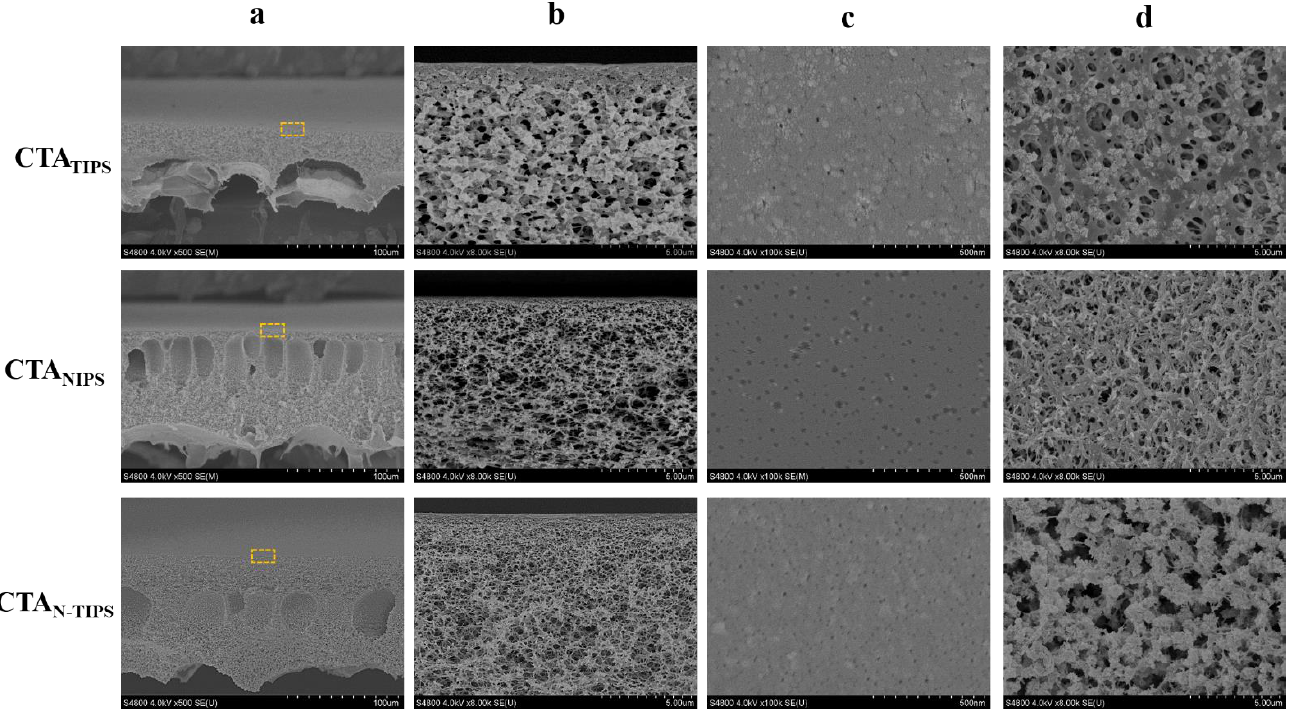
Figure 1. FESEM images of the cross-section ( a , b ); the top surface ( c ); and the bottom surface ( d ) of CTA porous substrates prepared by TIPS, NIPS and N-TIPS methods. The images of line b show the magnified morphology of the regions indicated by the rectangles in the images of line a.